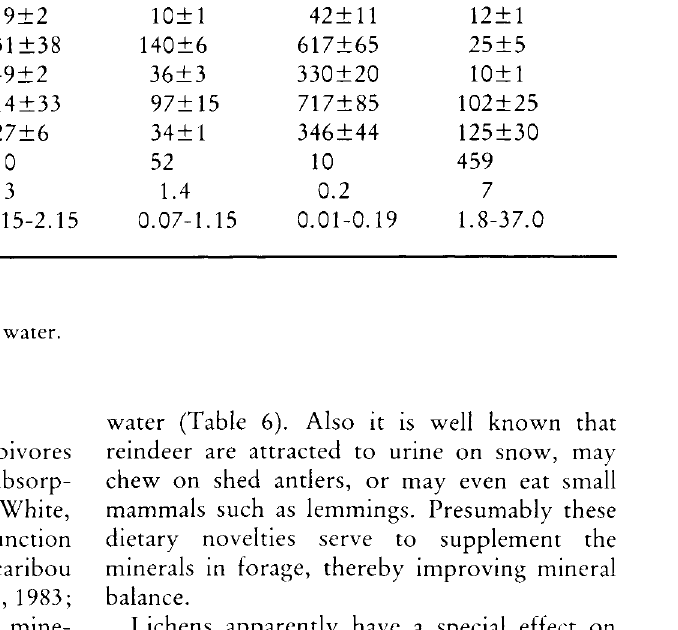
Table 6. Examples of natural sources of minerals (x mM/kg DM ± S.E.). Source N Ca Mg K Na Lichens 1 Horsetail 1 14 331±38 Grass